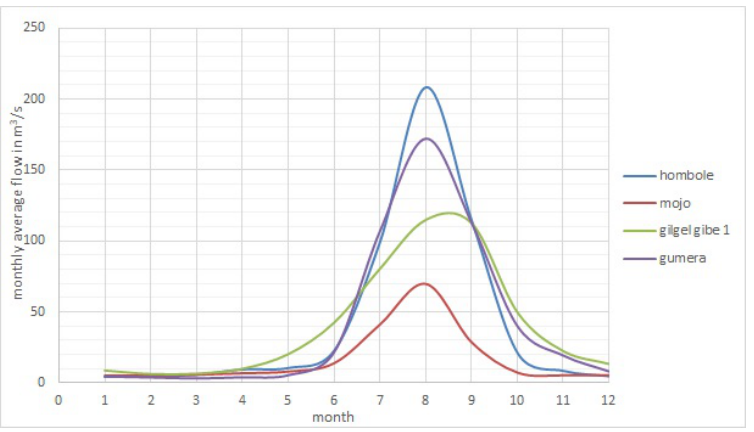
Figure 3. Monthly average outflow discharge at the main outlet point of each watershed under consideration.